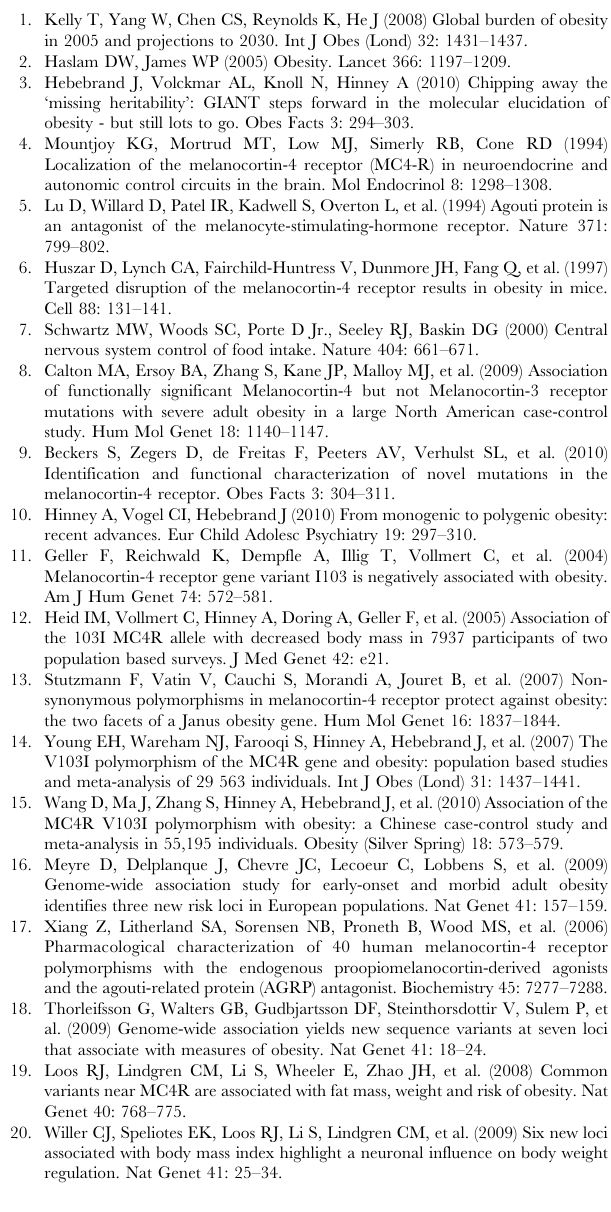
Table S7 CTCF binding sites within 250 bp of